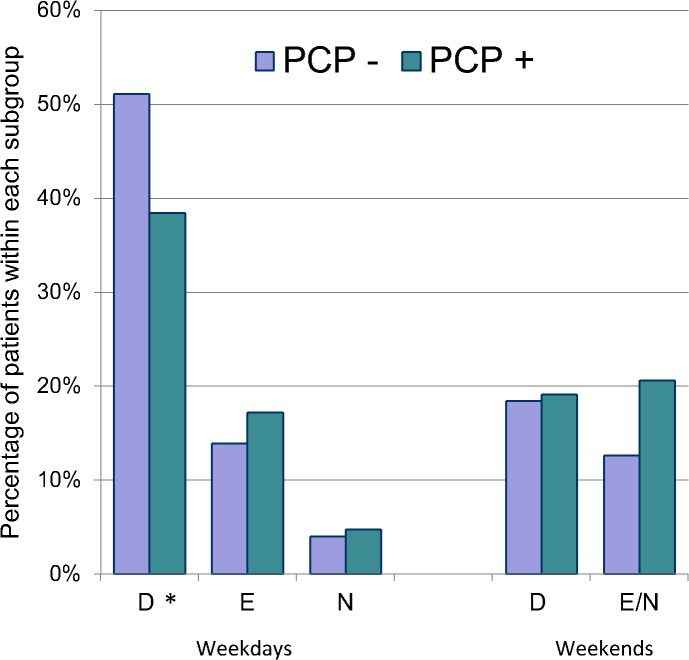
Time of Presentation to the Emergency Department.PCP-Patient does not have a primary care provider (n = 223). PCP+, Patient does have a primary care provider (n = 1,890). D, Days (08:00–17:00). E, Evenings (17:00–24:00). N, Nights (24:00–08:00). * p = 0.003.